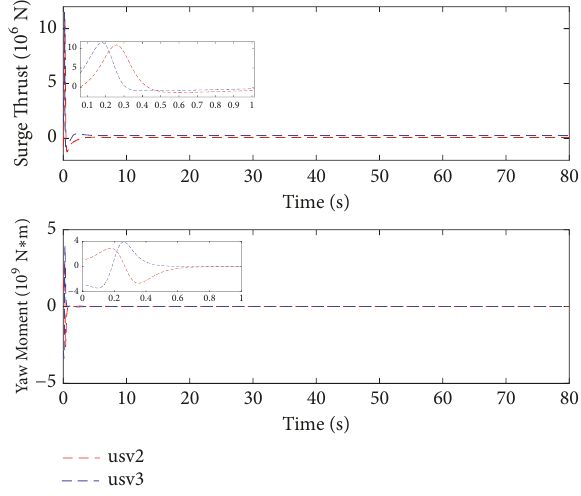
Figure 8: The force and torque of USV 2 and USV 3.